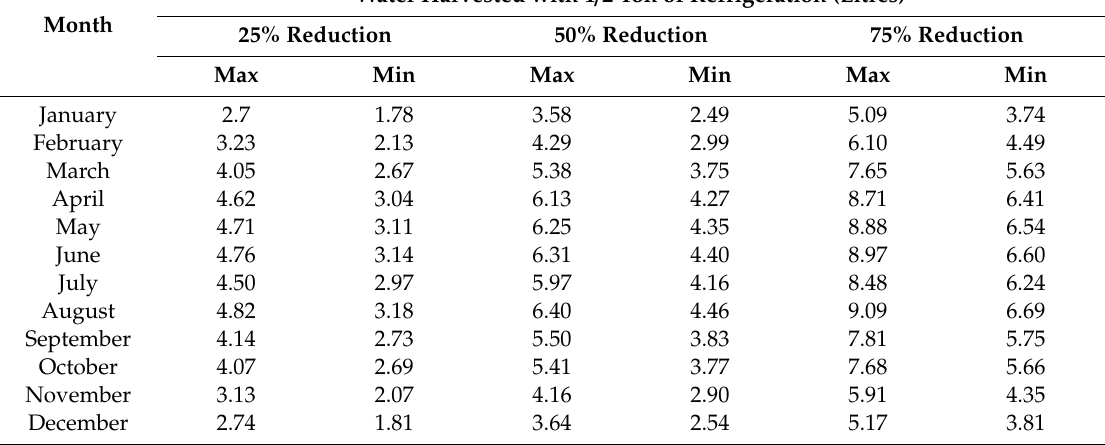
Table 5. Maximum and minimum amounts of water harvested in the months of the year with a compressor with 1 ton of refrigeration capacity. 2